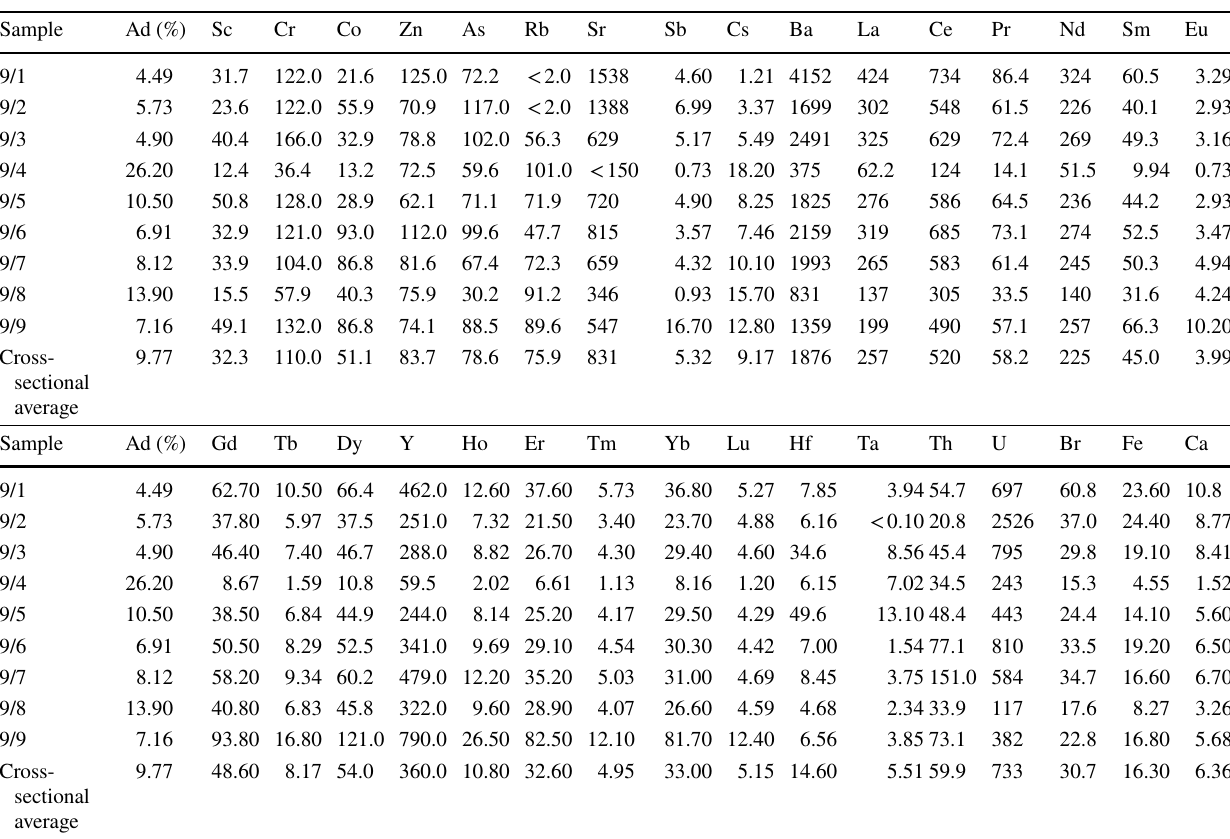
Table 1 Concentration of rare elements (g/t) in coal ash and rocks of coal-bearing sediments of the "West" section (analyzed by neutron activa- tion and for REE group—by atomic emission spectrometry)